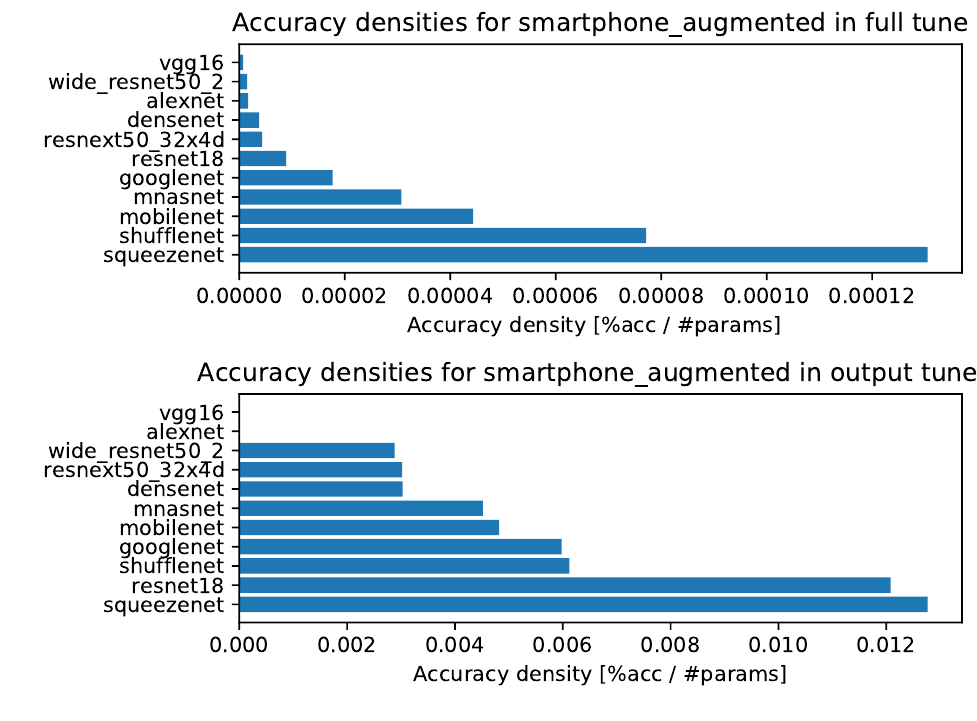
Figure A9. Accuracy densities for ten-episodes learning on augmented smartphone data.